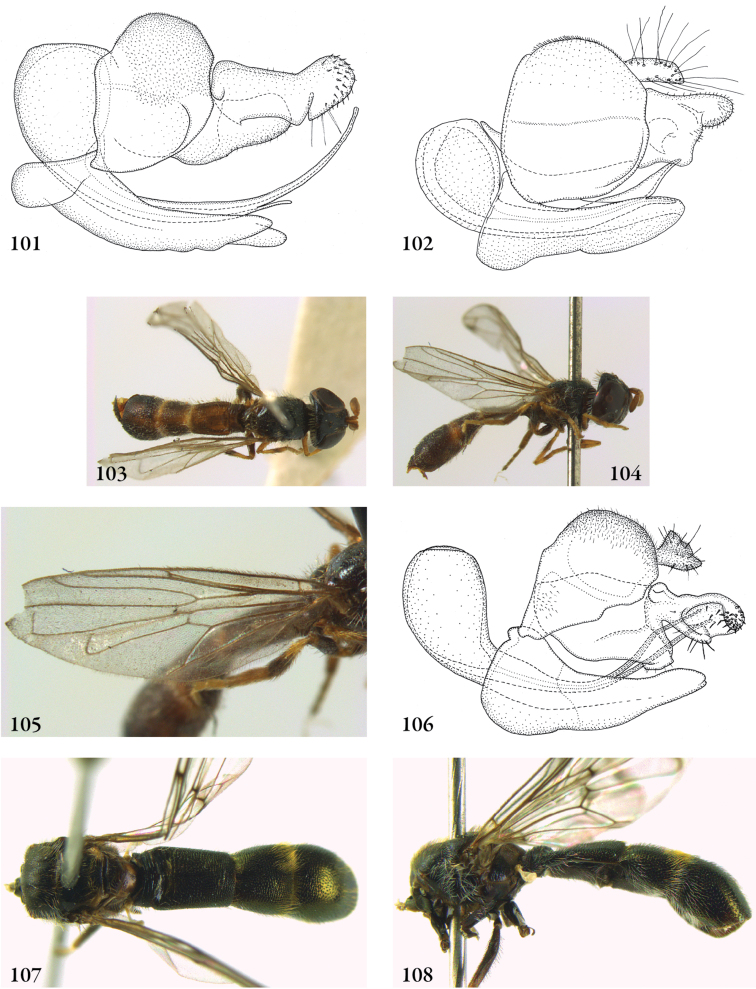
101–102
Hypselosyrphus, male genitalia: 101
Heliodon amazonicus (Peru, coll. RMNH) (cercus missing) 102
Heliodon analis (holotype) 103–106
Indascia gracilis male (holotype): 103 habitus dorsal 104 habitus lateral 105 wing 106 genitalia 107–108
Indascia gigantica male (holotype): 107 habitus dorsal 108 habitus lateral.